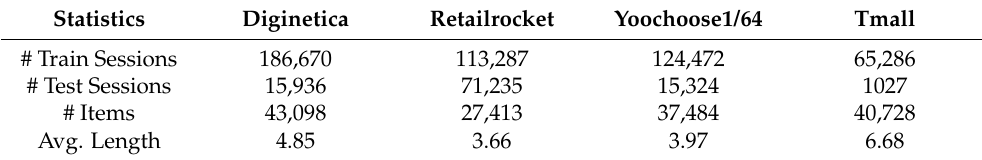
Table 1. Data Statistics.